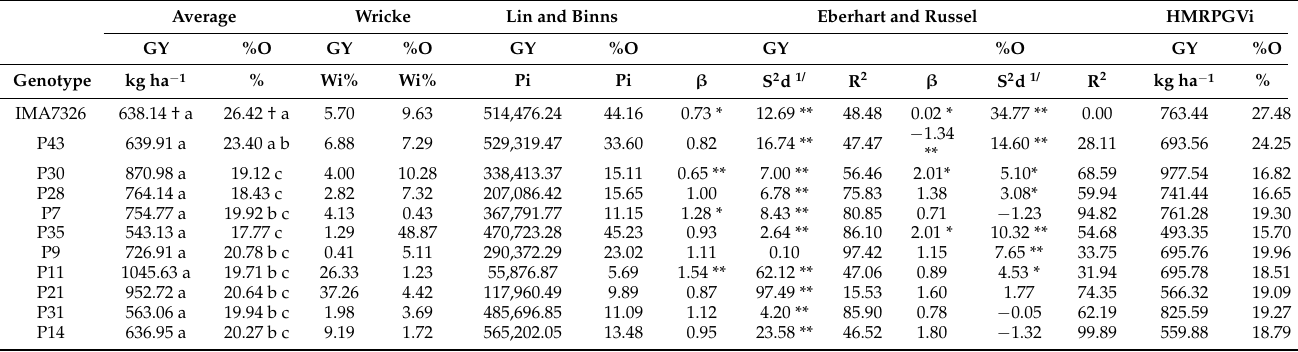
Table 3. Stability and adaptability of grain yield and oil content of safflower genotypes tested in four environments of the Brazilian Cerrado by the methodologies of Wricke, Lin and Binns, Eberhart and Russell, and